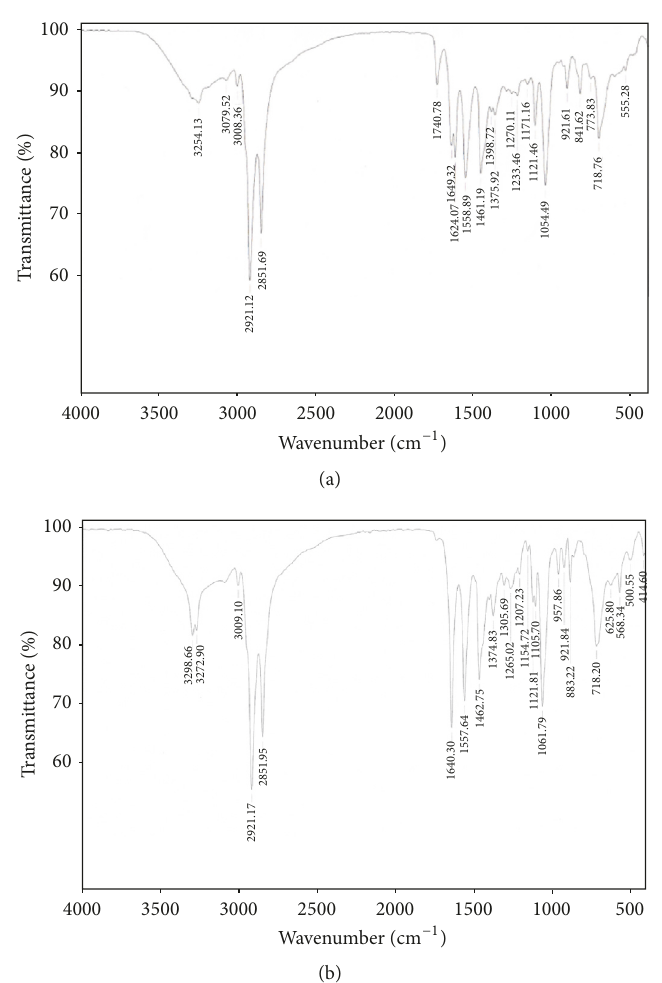
Figure 1: FT-IR spectra of the synthesis of the fatty amides from CRBO and AEEA: (a) initial mixture ( 𝑡 = 0 minutes reaction) and (b) final mixture (80 minutes